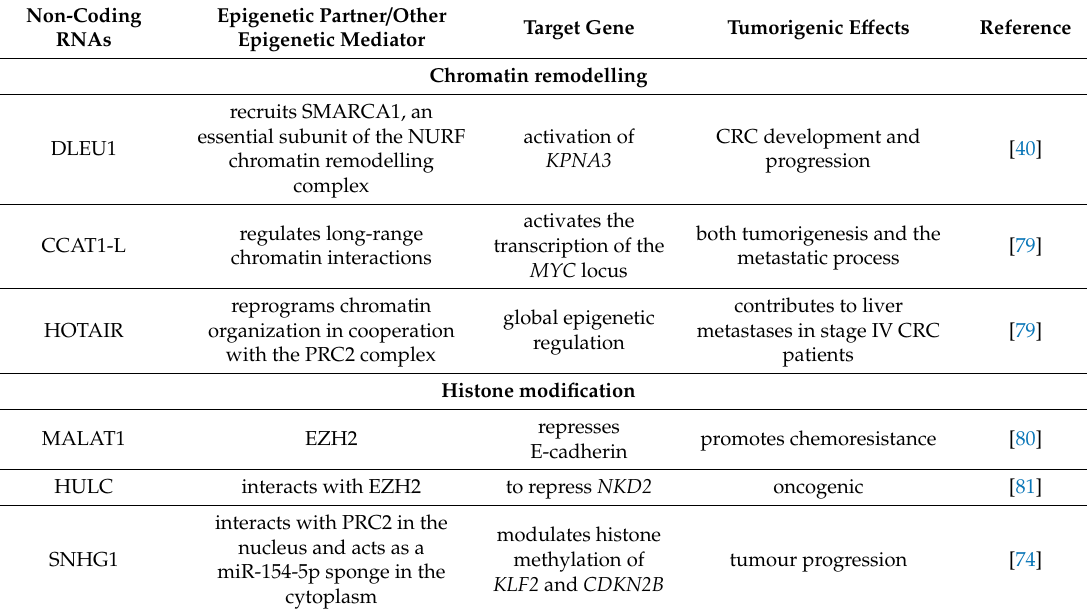
Table 2. Interplay of lncRNAs with other epigenetic partners in the pathogenesis of CRC. Non-Coding